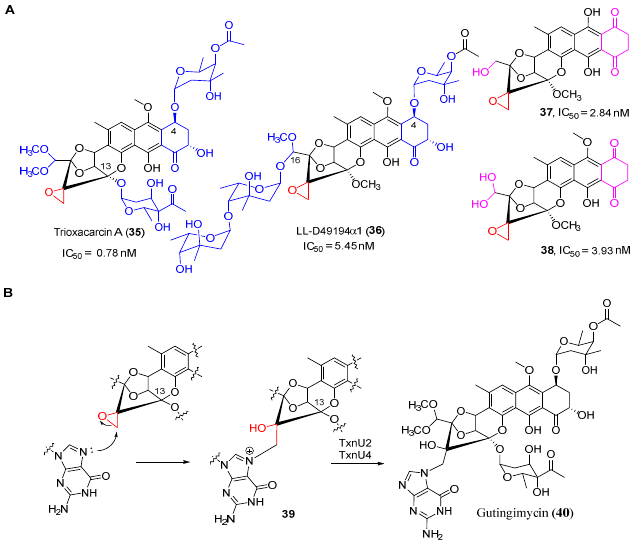
Figure 7. Proposed biosynthetic pathway of hedamycin. KS, ketosynthase; KR, ketoreductase; ACP, acyl carrier protein; DH, dehydratase; AT, acyl transferase.